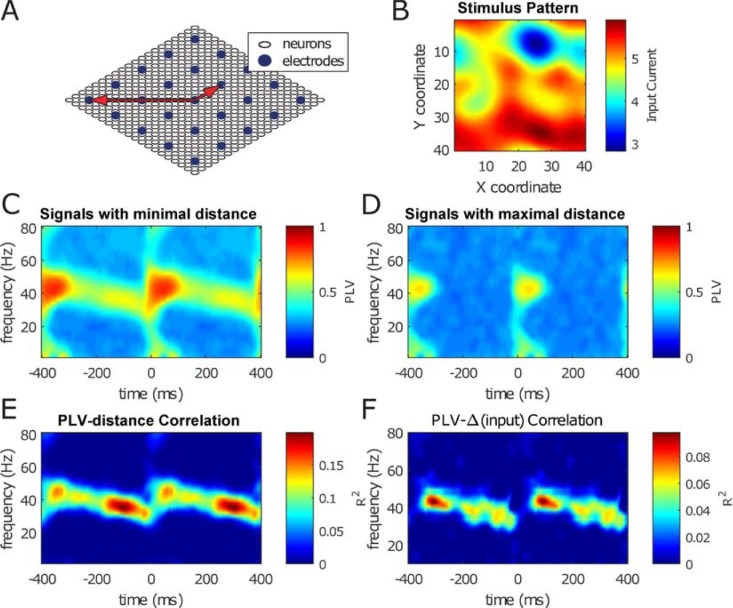
Synchrony across the network depends on connection strength and input difference more strongly during sustained gamma-band activity than during MS-induced transients.Synchrony was measured by PLV. (A) A scaled-down schematic representation of the model network. Inhibitory neurons are omitted for clarity. The full network consists of excitatory neurons placed on a square 40 × 40 grid together with a square grid of the same diameter containing 20 × 20 inhibitory neurons (not depicted). LFP electrodes are placed on a 10 × 10 grid spread equally across the 40 × 40 neuronal grid. The boundaries of the grid are periodic, i.e., the neurons are placed atop a toroidal surface. The 2 red arrows indicate 2 electrode pairs: a neighbor pair, at minimal distance, and a pair at maximal distance. (B) Network was driven by input consisting of retinotopically smoothed Gaussian white noise. This input current was modulated over time by multiplying it by the MS modulation kernel (see Fig 1A, below right) for a total of 50 MSs. The SNR factor of the temporal Gaussian noise was equal to 2 (see Materials and methods). (C) Mean synchrony strength expressed as the mean PLV (see Materials and methods) across MSs between neighboring LFP electrodes (see smallest of the red arrows in panel A). (D) Same as panel C, but now between LFP electrodes with maximal distance to each other (see longest of the red arrows in panel A). Note the lack of synchrony in the gamma band during the sustained period (t = 150–350 ms). (E) The correlation coefficients between electrode distance and PLV for a broad range of frequencies and all intersaccade time points. Only the synchrony in the narrow-band gamma activity (25–50 Hz) during the sustained period depends on the electrode distance. (F) The same as panel E but for stimulus input differences. Only the neuron pairs that are within 4 interneuron distances from each other were used for generating this figure. Neurons further apart have little to no synchrony during the sustained period (i.e., the correlation in panel E is negative) and were therefore not included. LFP, local field potential; MS, microsaccade; PLV, phase-locking value; SNR, signal-to-noise ratio.